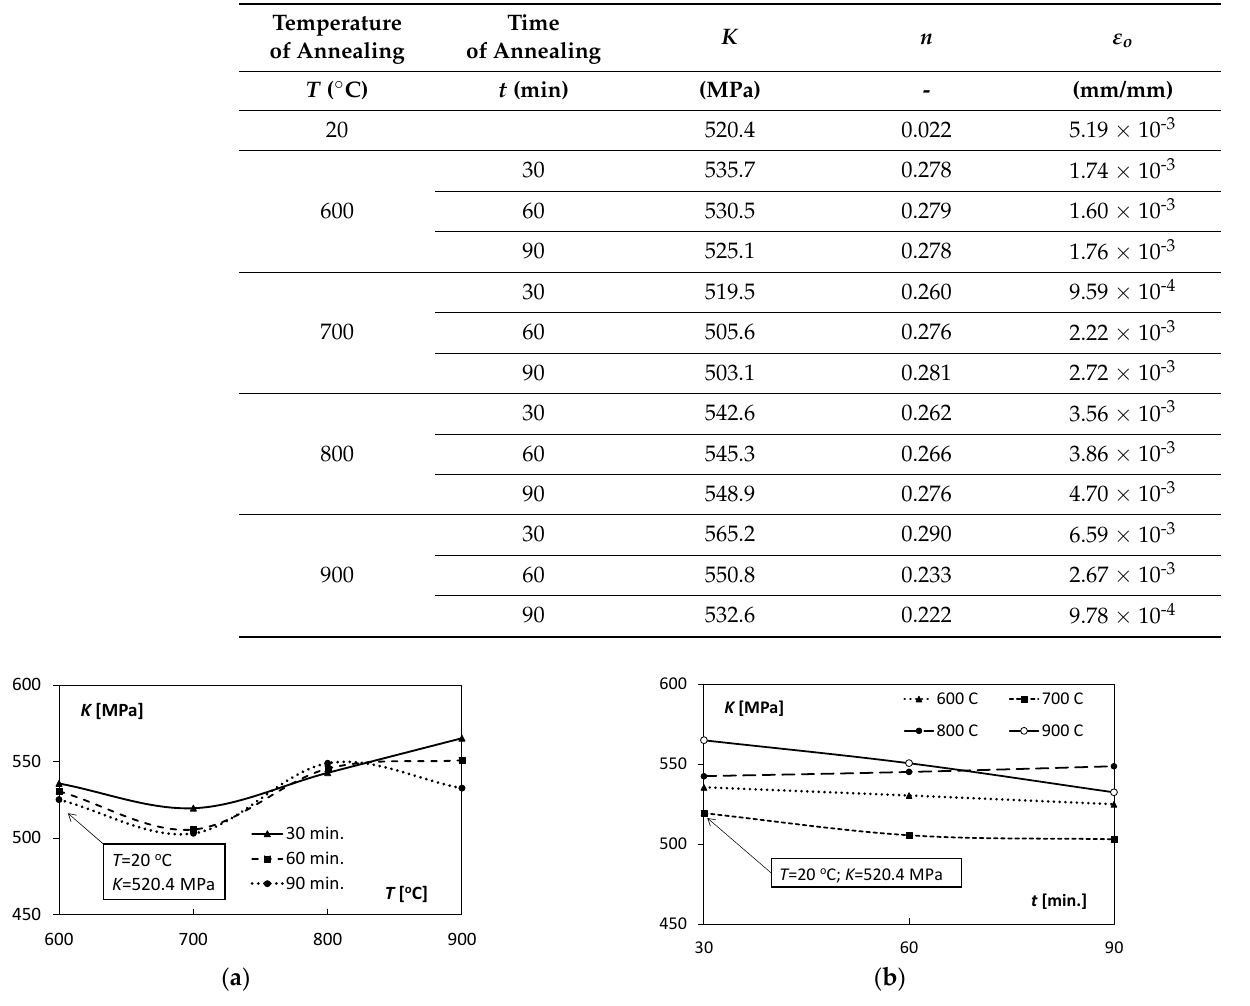
Table 4. Values of the hardening curve coefficients approximated by the Swift Equation (5).